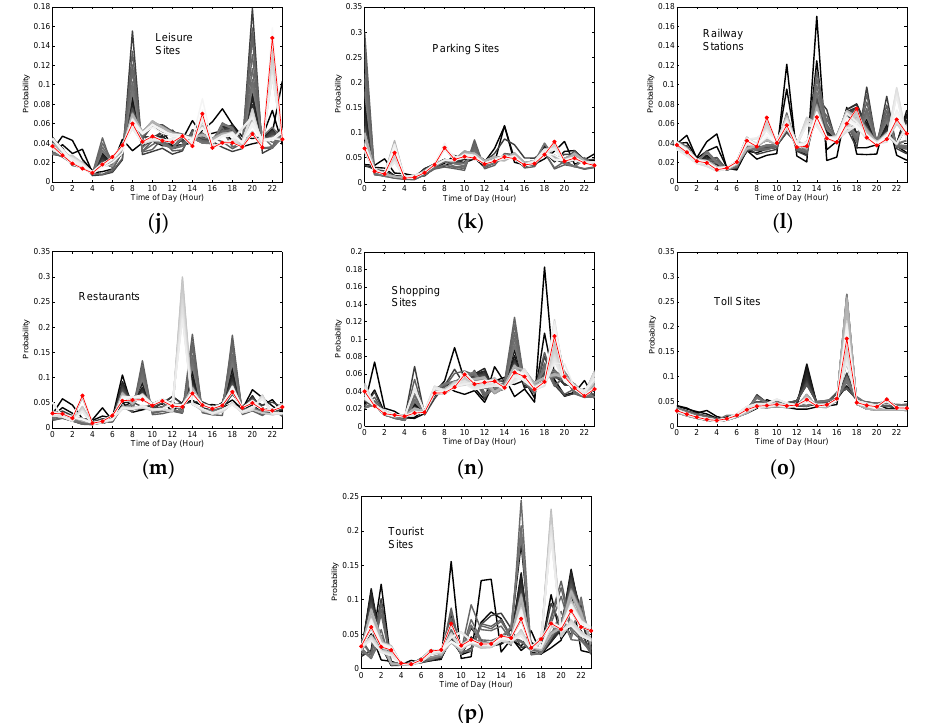
Figure 6. The probability of observing one stopping location at times of day for (a) airport, (b) commercial buildings, (c) bus facilities, (d) residential districts, (e) education sites, (f) financial sites, (g) gas station, (h) healthcare facilities, (i) hotel, (j) leisure sites, (k) parking sites, (l) railway stations, (m) restaurants, (n) shopping sites, (o) toll sites and (p) tourist sites, where x -axis is in hour and y -axis is the probability. (Note: In this figure, the curves with color changing from black to white are calculated by using the stopping locations from one day to 75 days respectively, and the curve with the red dotted line indicates the saturated one calculated by using all stopping locations of 75 days; this figure suggests that different types of POI might function differently in the time of day, for instance, airport, bus station and railway station present a relatively stable visiting pattern during daytime, residential district or commercial building displays roughly two peaks in the morning and in the afternoon, and leisure sites show a clear peak around 22:00 at night).